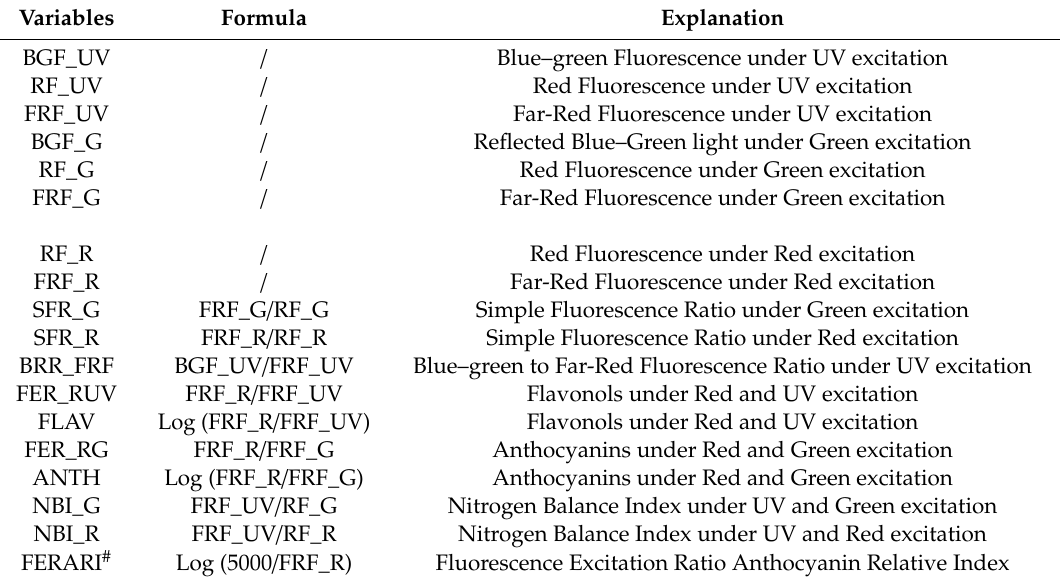
Table 2. Description of the variables and indices recorded by the Multiplex sensor (modified from Table 1 by Zhang et al.